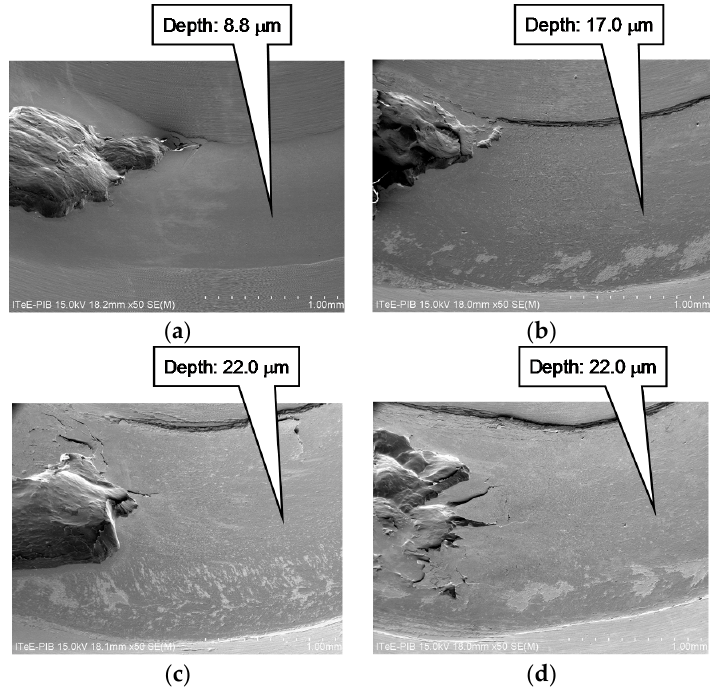
Figure 10. SEM images of the wear tracks on the test cones: ( a ) Uncoated cone lubricated with the mineral oil; ( b ) (W ‐ DLC/CrN) ‐ coated cone lubricated with the mineral oil; ( c ) (W ‐ DLC/CrN) ‐ coated cone lubricated with the PAO oil; and ( d ) (W ‐ DLC/CrN) ‐ coated cone lubricated with the PAG oil.